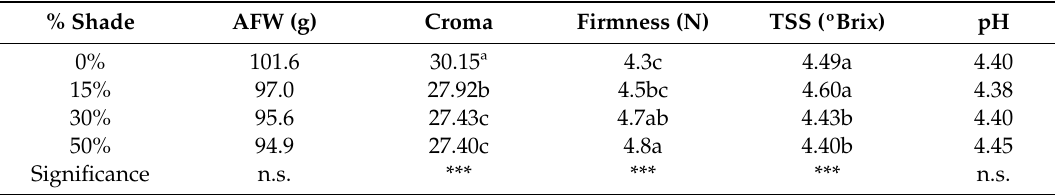
Table 2. Shading e ff ects on the fruit